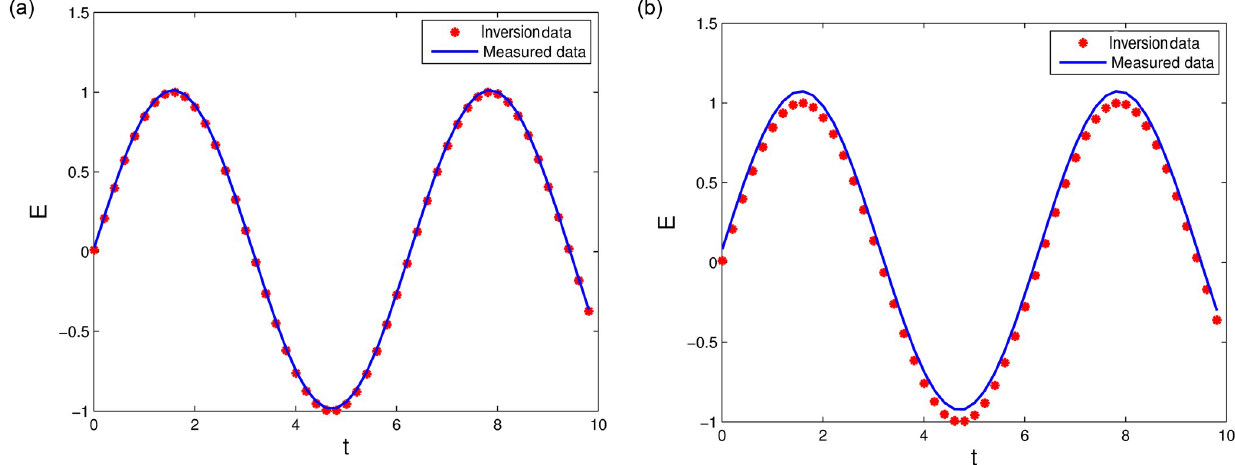
Fig 7. Measured data and inversion data under disturbance σ = 0.01 (left) and σ = 0.05 (right).